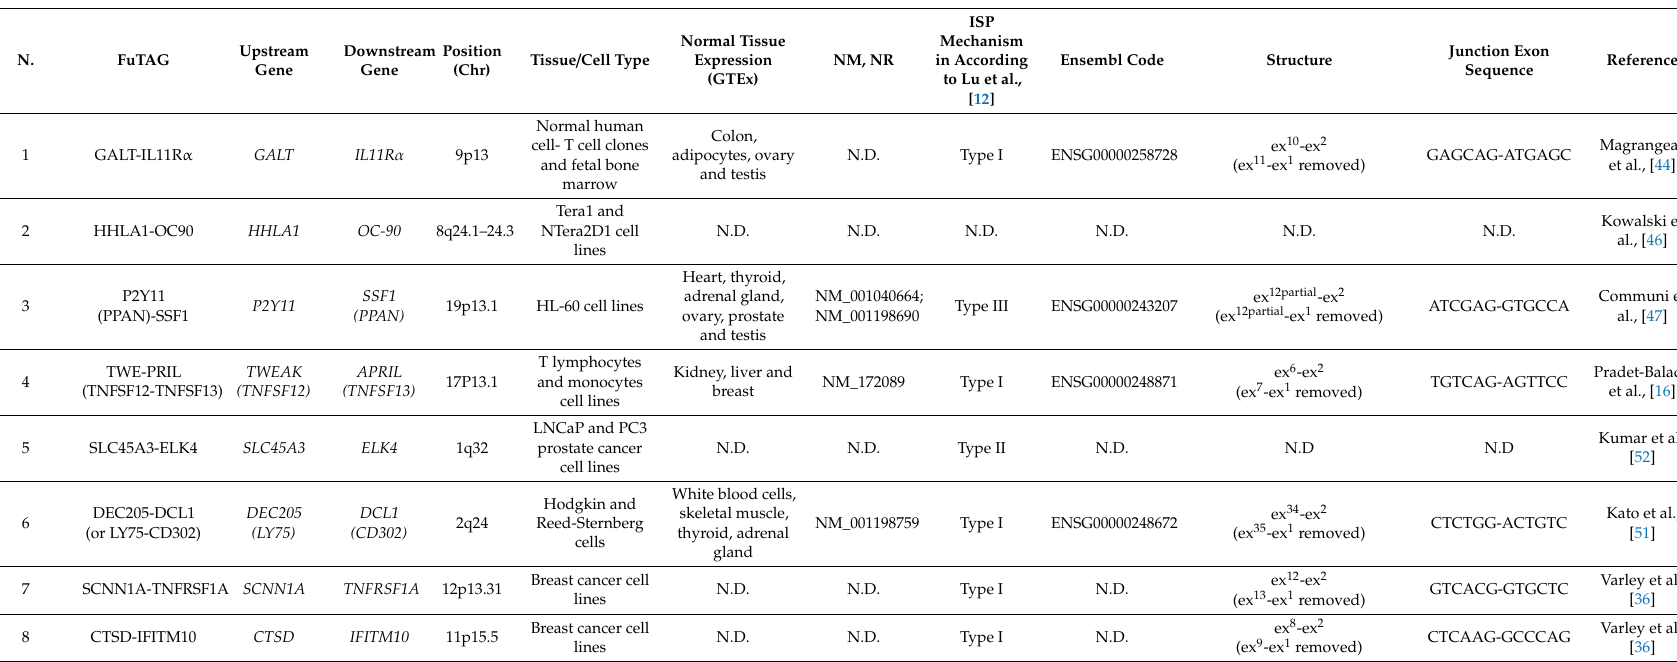
Table 1. List of experimentally evaluated FuTAGs. Additional exons are highlighted in green letters. Chr: Chromosome; NM and NR: NCBI curated Refseq accession numbers for coding and non-coding transcripts,